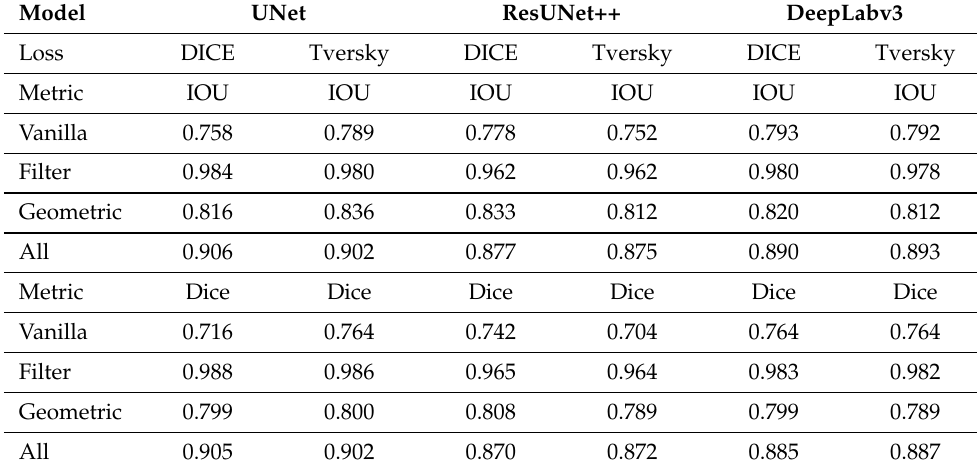
Table 7. The performance according to various data augmentation techniques in augmented Ultrasound datasets.